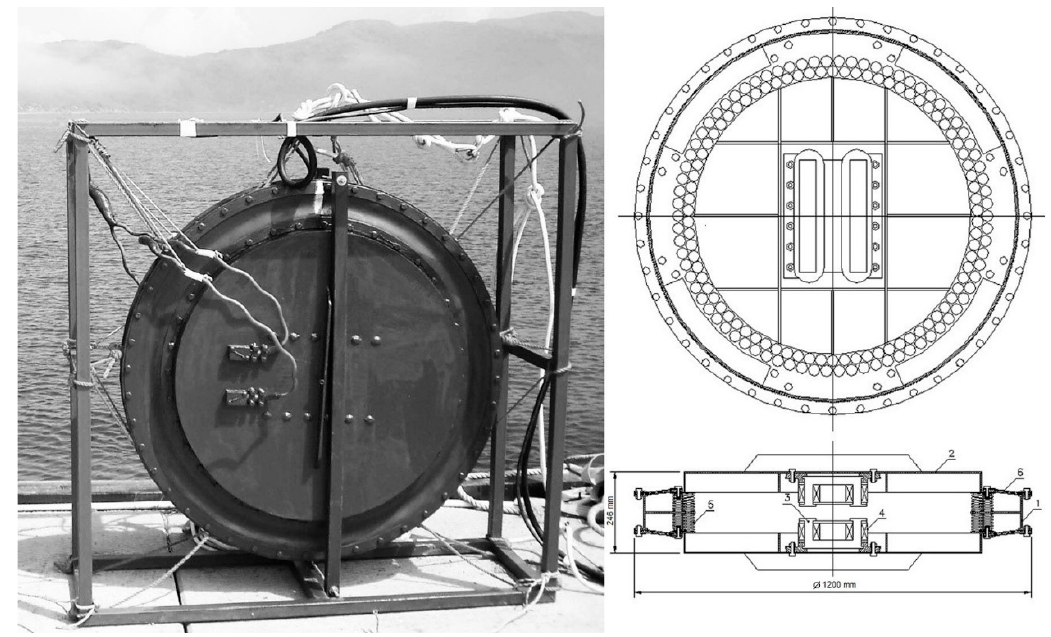
Figure 2. Hydroacoustic transmitter of 19–26 Hz.